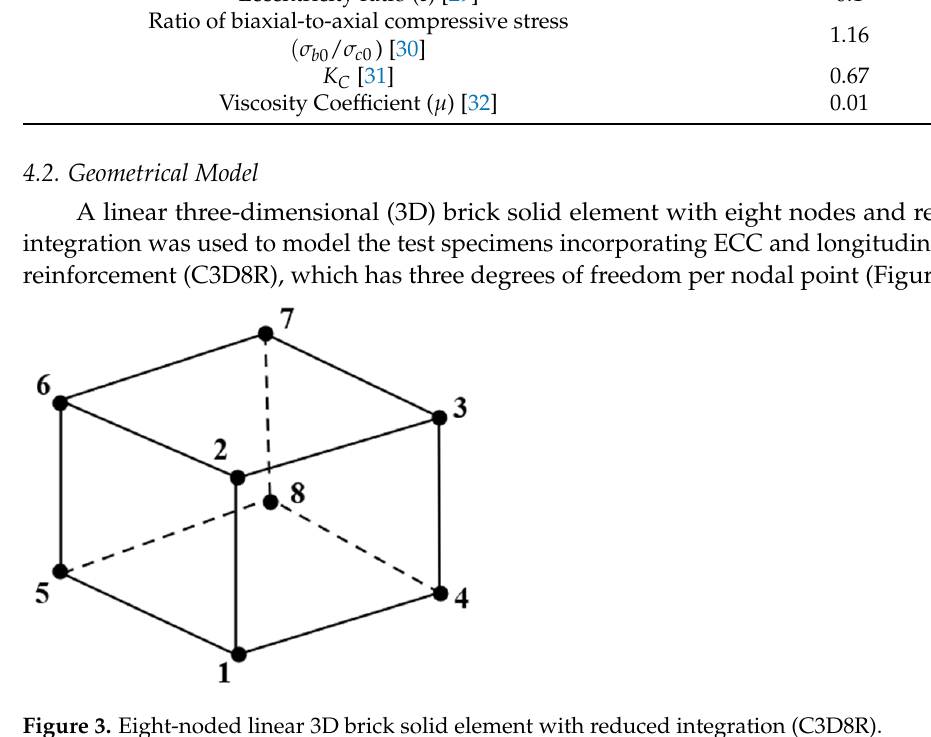
Table 2. Input parameters for ECC.